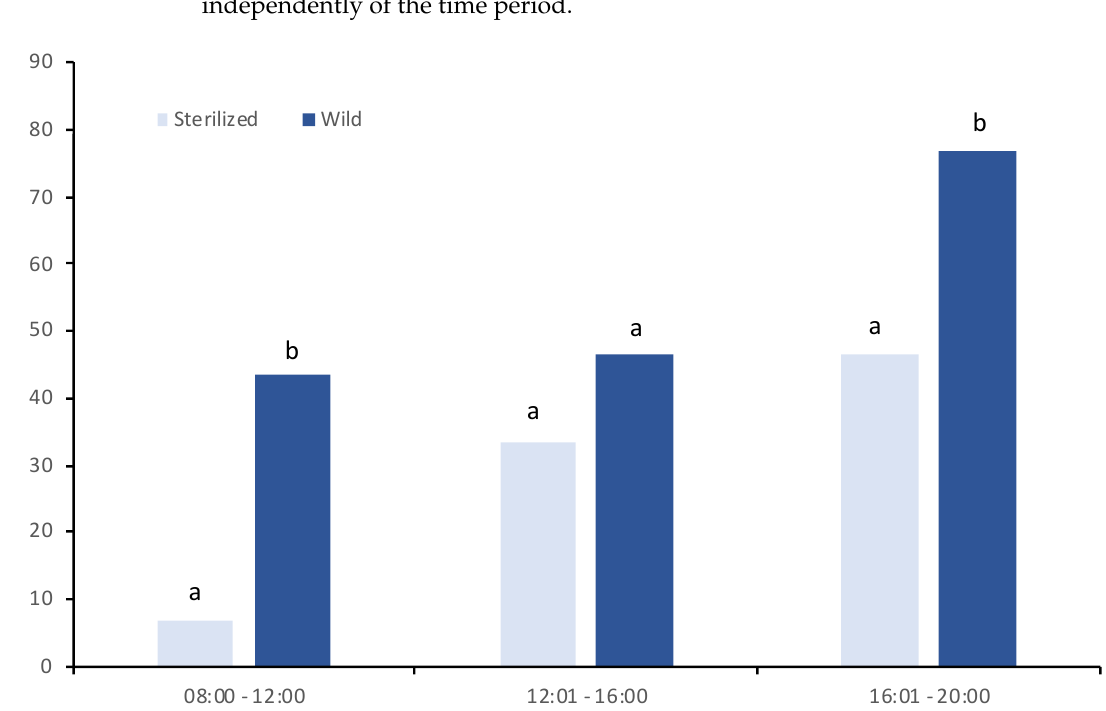
Figure 4. Daily patterns of mating for wild and sterilized males when wild virgin females were offered in a no choice experimental set up. Different letters indicate significant differences within each time interval ( p < 0.05).